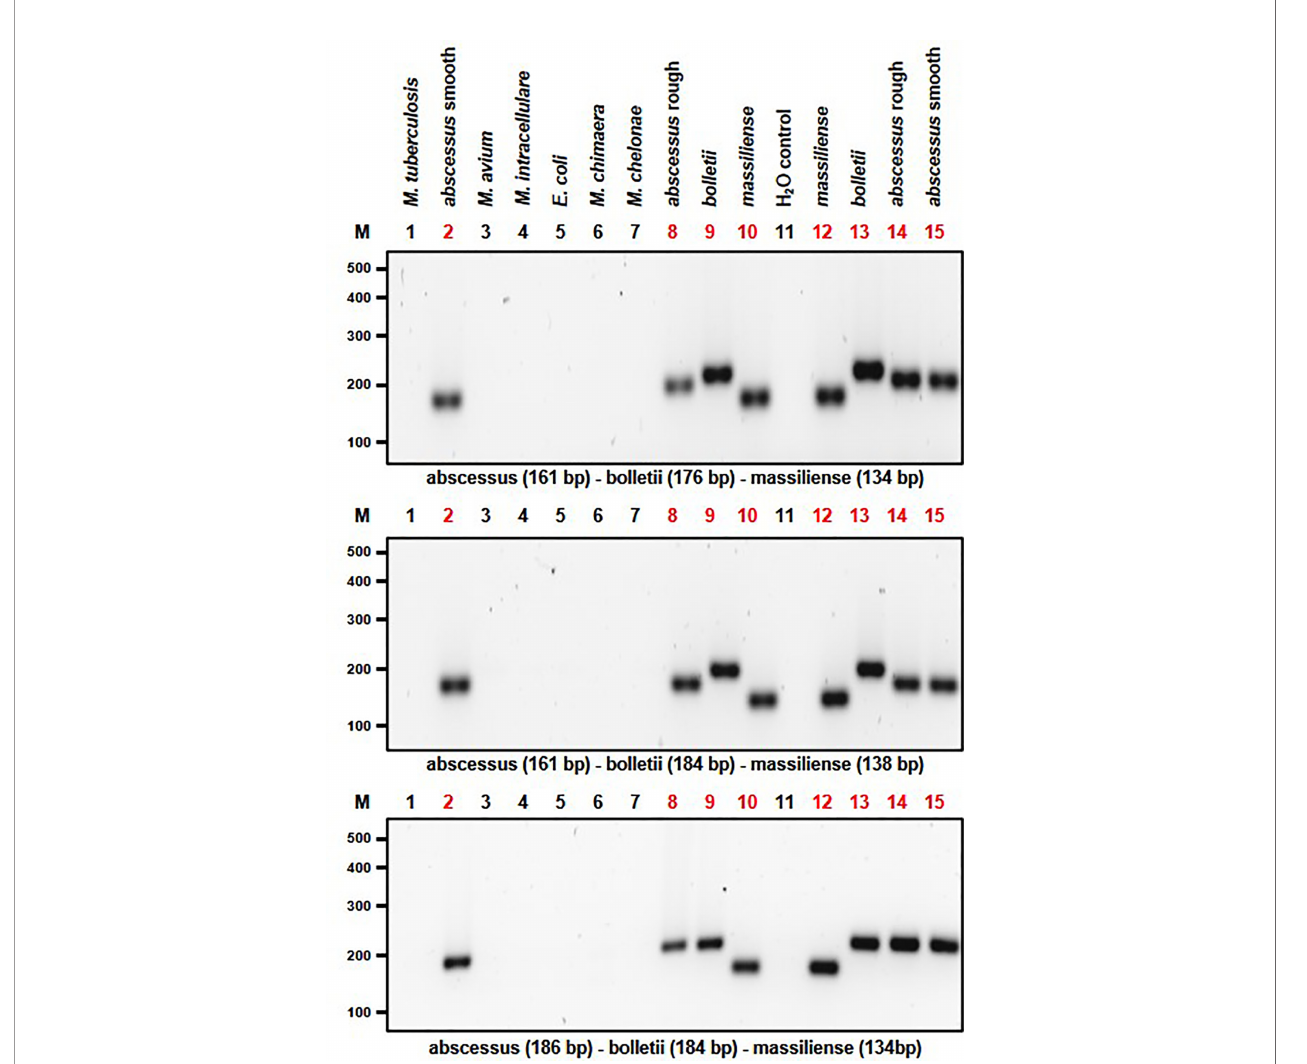
FIGURE 4 | Multiplex PCR assay capable of differentiating MABC subspecies. Multiplex PCR A produced amplicon sizes of 161bp, 176bp and 134bp for M. abscessus for both rough and smooth morphotypes, M. bolletii and M. massiliense , respectively (Top Panel). Multiplex PCR B produced amplicon sizes of 186bp, 184bp and 138bp bands for M. abscessus for both rough and smooth morphotypes, M. bolletii and M. massiliense , respectively (Middle Panel). Multiplex PCR C was able to identify M. abscessus for both rough and smooth morphotypes, M. bolletii and M. massiliense according to their product sizes of 161bp, 184bp and 134bp, respectively (Bottom